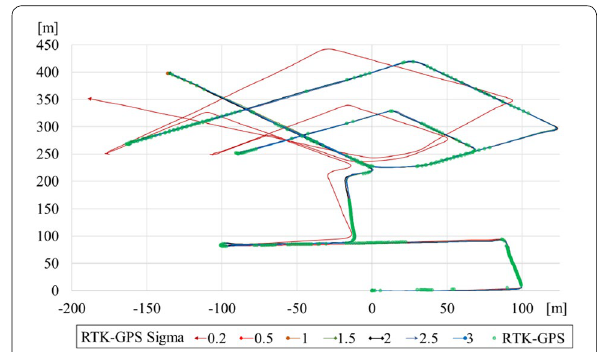
Fig. 5 Fast-SLAM trajectory result based on RTK-GPS sigma values, which are 0.2 (dark red), 0.5 (red), 1.0 (brown), 1.5 (green), 2.0 (black), 2.5 (dark blue), and 3.0 (blue). RTK-GPS measurement (cyan)